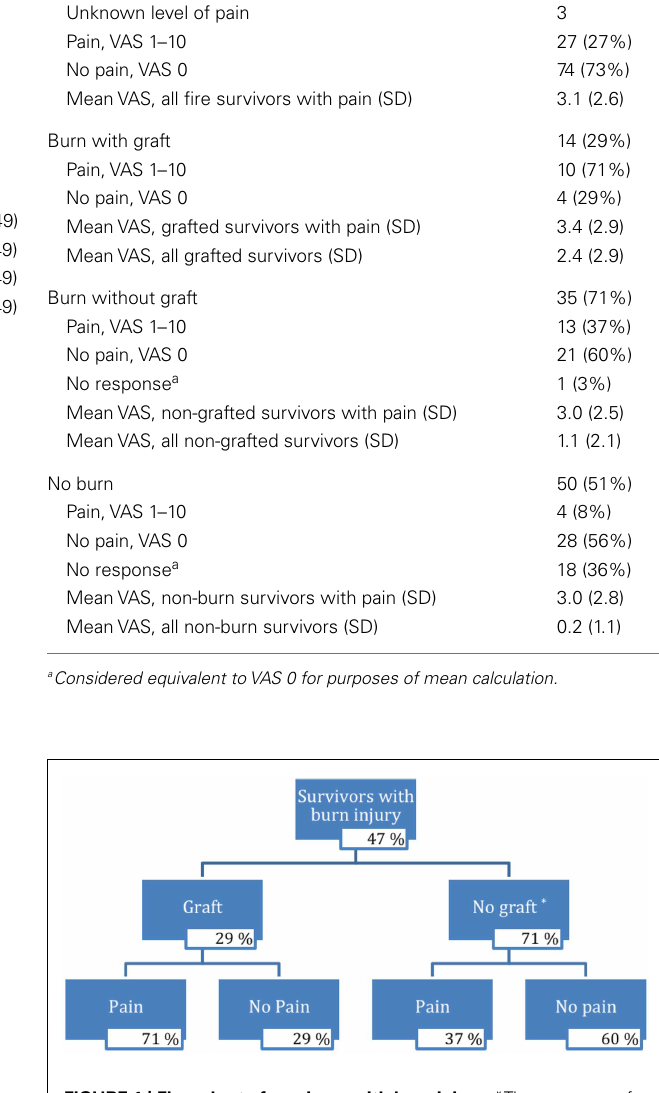
FIGURE 1 | Flow chart of survivors with burn injury . *Three percent of burn injury survivors who did not receive a graft did not respond.